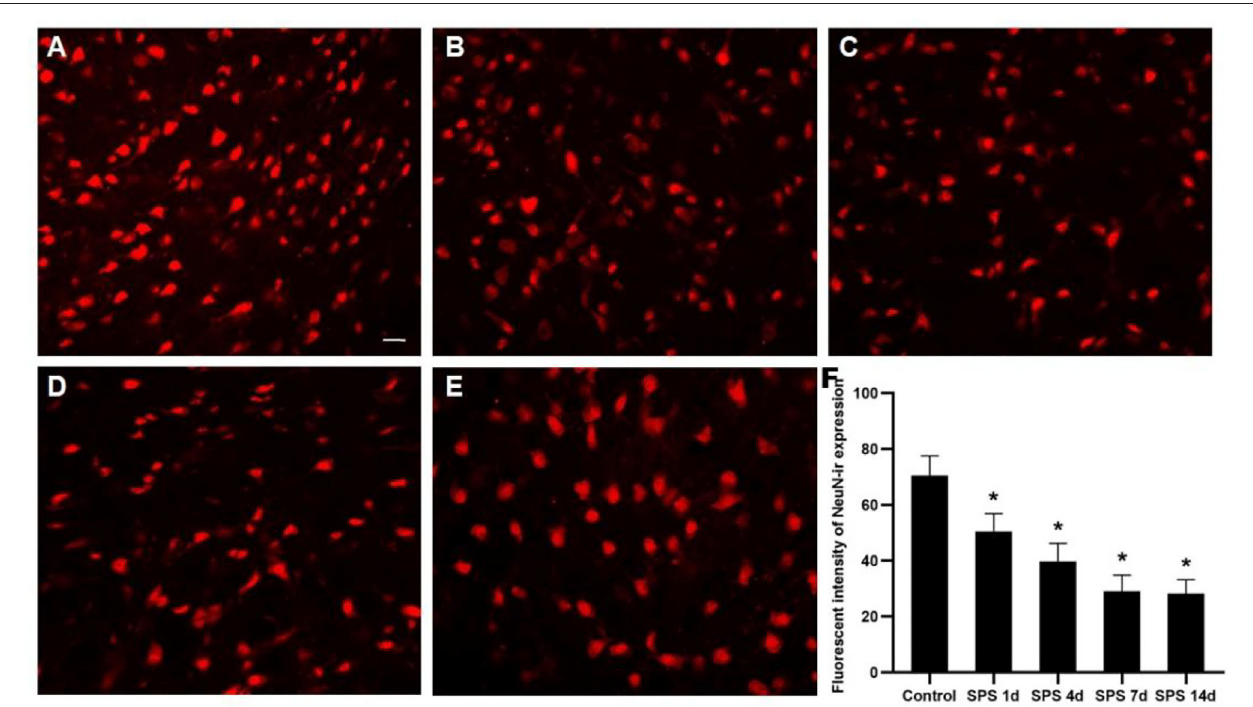
FIGURE 7 | Immunofluorescence observations of GFAP in mPFC. Representative images of GFAP immunoreactivity (IR) and results analysis in mPFC (magnification × 400, Bar = 20 µ m): (A) control group; (B) SPS 1d; (C) SPS 4d; (D) SPS 7d; (E) SPS 14d. (F) Quantity analysis of GFAP-IR expression in mPFC in each group. * P < 0.05 vs. control